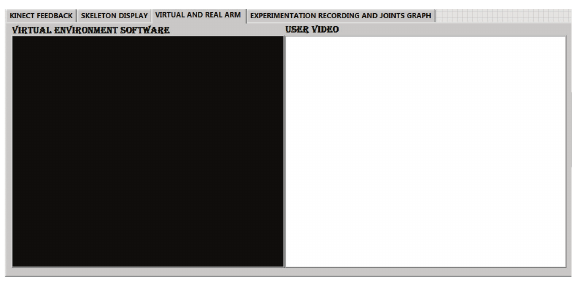
Figure 7: Third screen of the user interface.